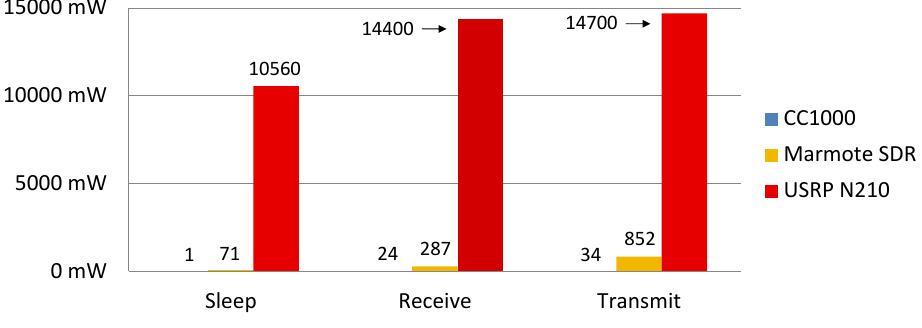
Figure 3. Power consumption comparison of the CC1000 commodity radio-frequency (RF) chip, the Marmote SDR platform and the USRP N210 in various power